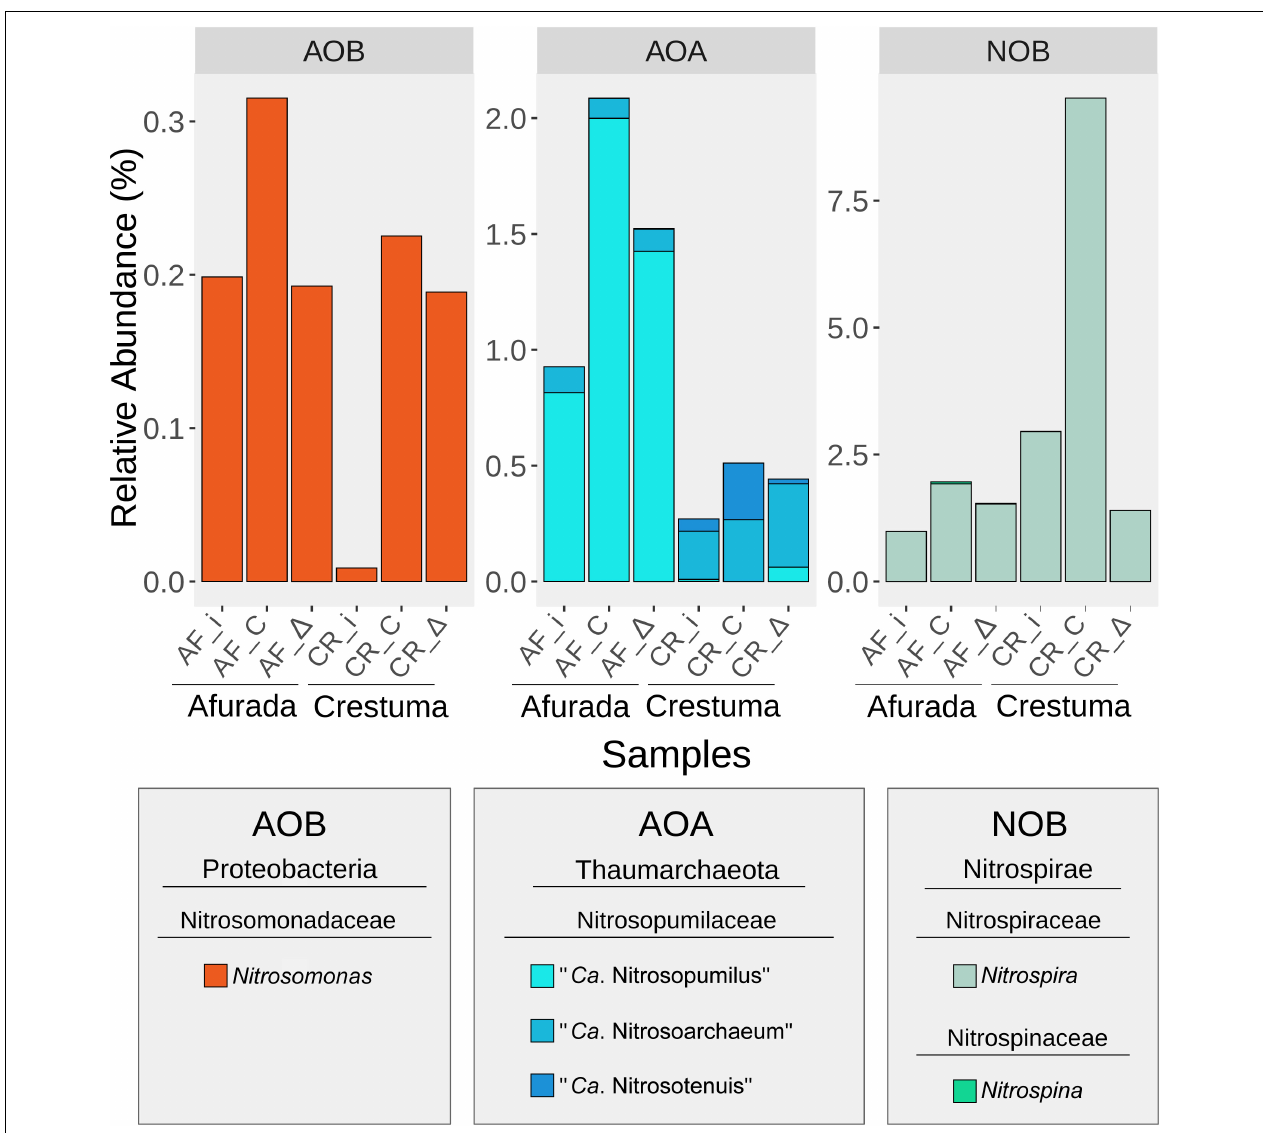
FIGURE 4 | Bar plot representing the relative abundance of the identified nitrifying taxa at genus level in the initial sediment (AF_i and CR_i) as well as in the sediment samples of the different salinity treatments (constant – AF_C and CR_C, and fluctuation – AF_ (cid:49) and CR_ (cid:49) ). Samples under different salinity treatments were depicted as mean relative abundances of genera from original sample replicates ( n =